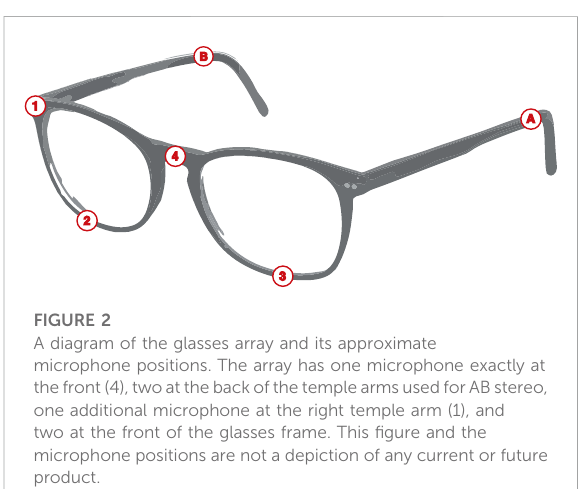
FIGURE 3 Magnitude spectra of frontal binaural signals rendered with BFBR with different numbers of beams, based on a single plane wave impinging on an EMA6 from the frontal direction. Additionally, a frontal HRTF of a KU100 dummy head for the frontaldirectionisdepicted.TheBFBRsignalswerecalculatedwith 12, 32, 240, and 1730 uniformly distributed